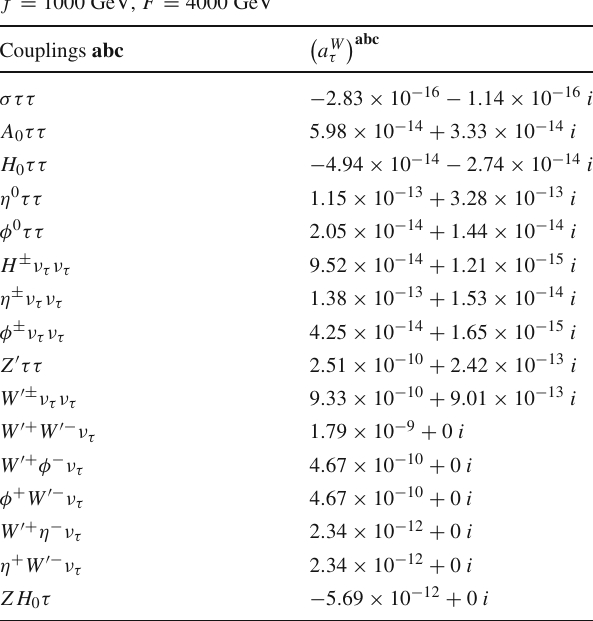
Table5 Themagnitudeofthepartialcontributionsto a W τ oftheBLHM. The data are obtained by fixing the f and F scales, f = 1000 GeV and F = 4000 GeV. The values provided in Table 3 are used for the rest of the model parameters. abc denotes the different particles running in the loop of the vertex Z τ + τ − f = 1000 GeV, F = 4000